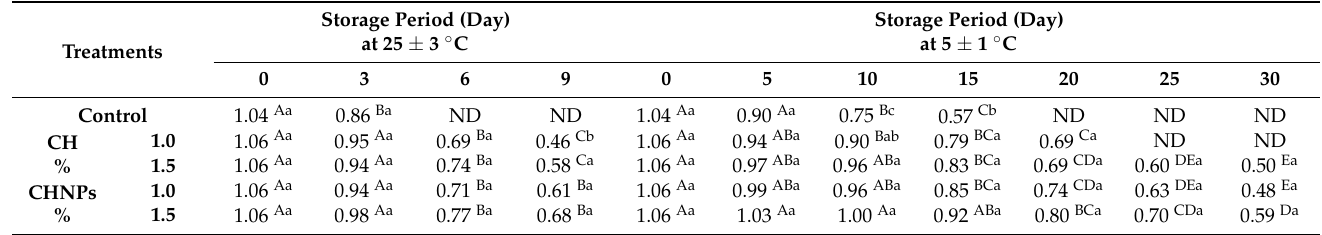
Table 3. Effect of coatings on the total acidity of apricot fruits during